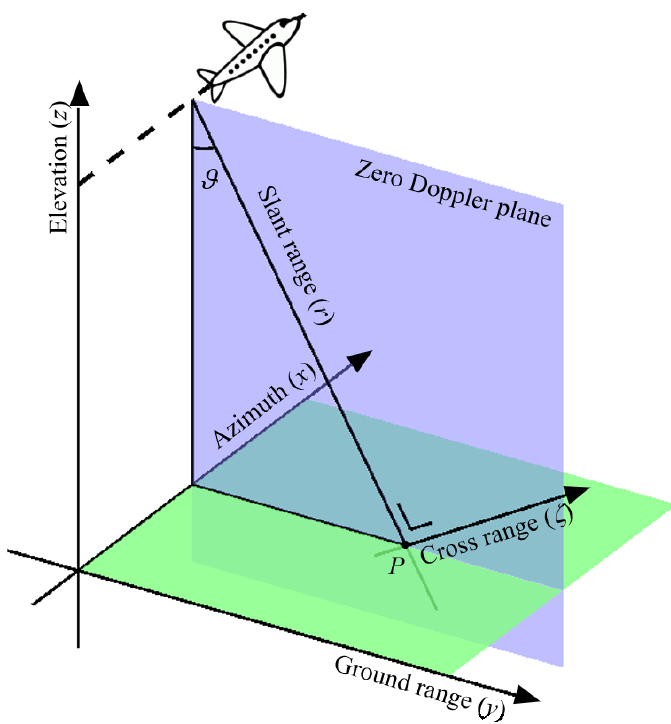
Figure 1. Schematic representation of a zero squint synthetic aperture radar (SAR) acquisition. The off-nadir angle ϑ (also known as look angle) defines the line-of-sight and hence the cross range axis ζ ; both of them lying in the zero-Doppler plane, orthogonal to azimuth. The cross range (proportional to the elevation) is a blind direction for single-image SAR systems: sensitivity to the ζ direction is provided by interferometric or tomographic SAR